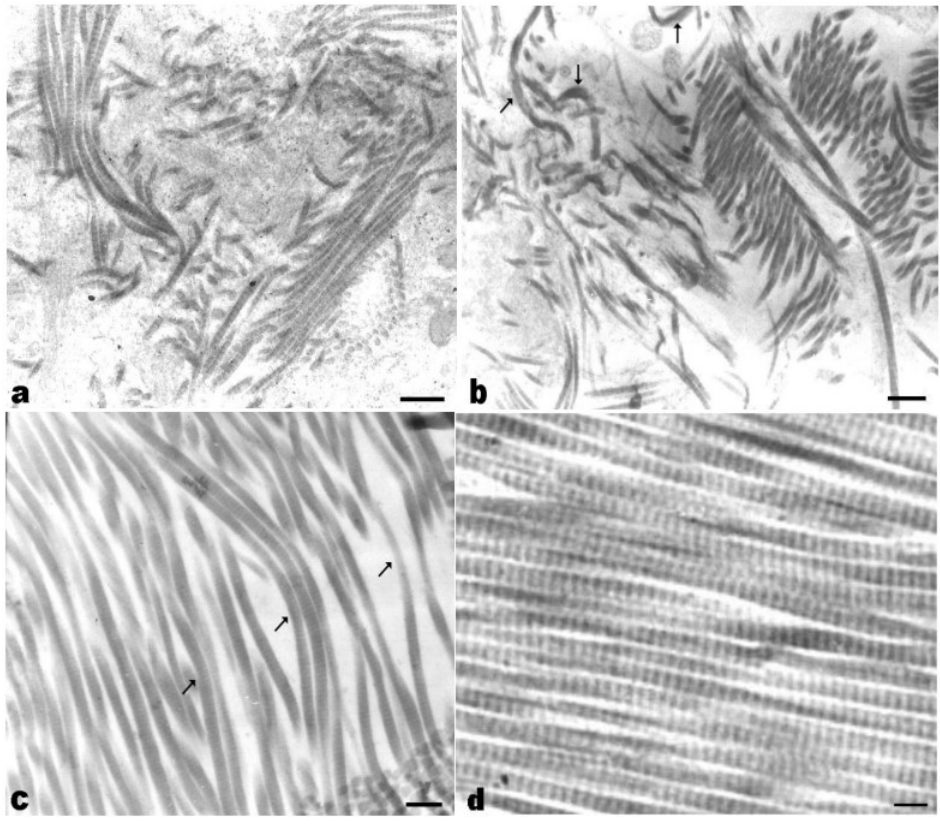
FIGURE 3. Effects of lithium on rabbit skin collagen. (a,b) The arrangement of fibrils is very disorganized. In some arrays, fibrils change their orientation forming a “hairpin loop” (b, shown with arrows). (c) Helical twisting (indicated with arrows) is also apparent. Animals were injected with 1.5 meq Li/kg for 30 consecutive days and were sacrificed 1 day, 2, and 6 months after the last lithium injection, respectively. (d) Skin fibrils packed in roughly parallel array from normal rabbits. Bar = 0.9